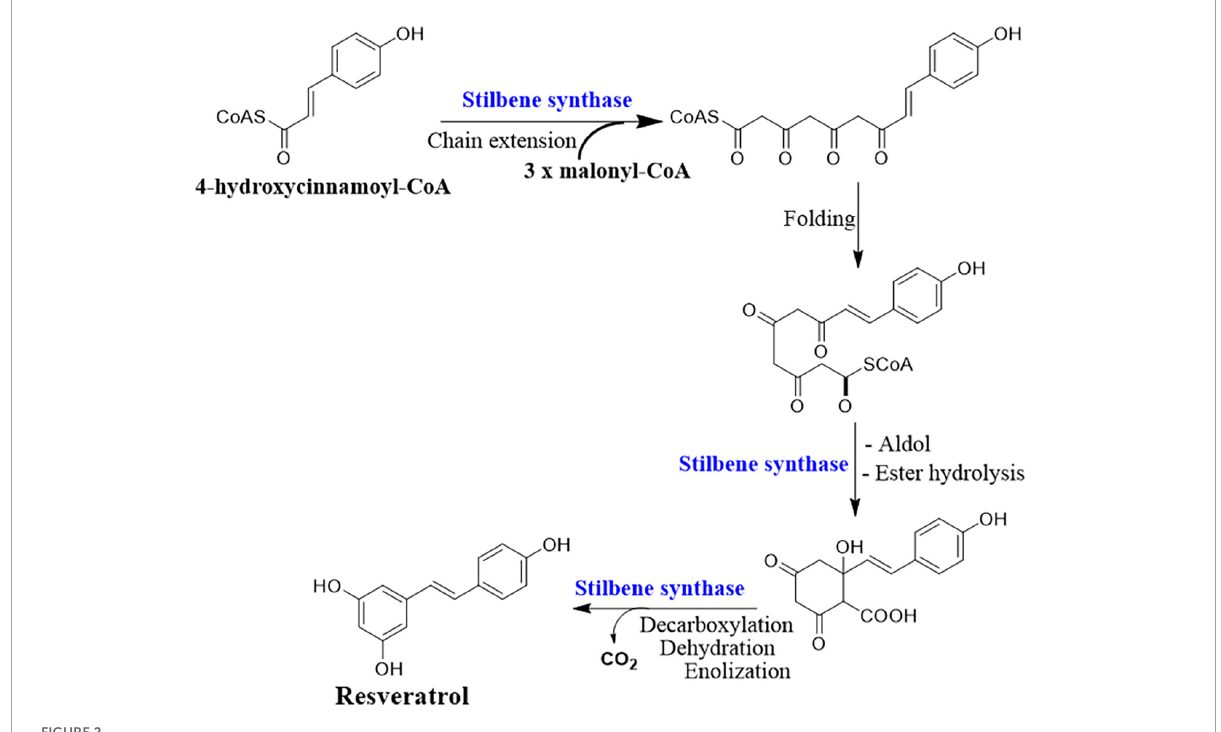
FIGURE2 Resveratrol biosynthesis pathway.